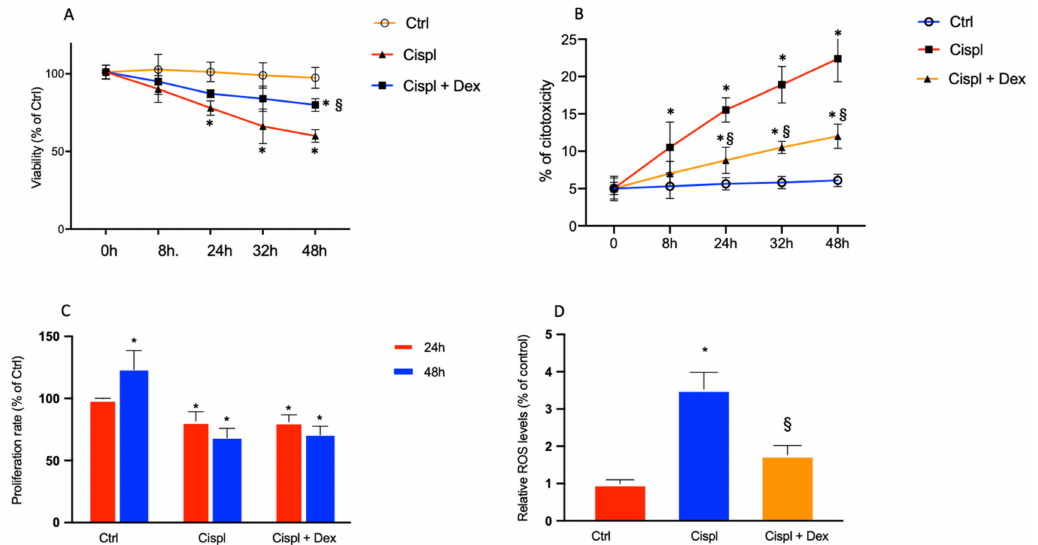
Figure 2. Effects of the treatments for 8 h, 24 h, 32 h and 48 h with 30 µ M cisplatin in the absence or in the presence of 10 nM dexamethasone on BCPs were evaluated by MTT assay (cell viability) ( A ) and LDH release (cytotoxicity) ( B ). Effects of the treatments for 24 h and 48 h with 30 µ M cisplatin in the absence or in the presence of 10 nM dexamethasone on BCPs were evaluated by crystal violet assays (proliferation rate) ( C ) and an H2DCFDA assay (ROS levels) ( D ); each treatment is represented by a different color: control cells are red, cisplatin-treated cells are blue and cells treated with cisplatin plus dexamethasone are orange. The values are expressed as the mean ± SD of results from three different experiments, with four parallel samples for each group in each experiment. * p < 0.05 vs. cells without treatment at the same incubation time; § p < 0.05 vs. cells treated with cisplatin. The non-parametric Mann-Whitney test was used for pairwise